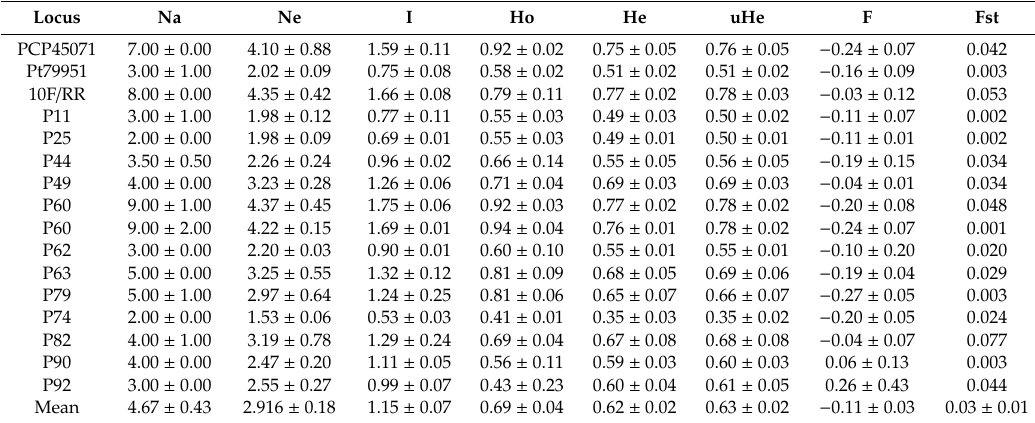
Table 2. Diversity statistics of the 16 microsatellite markers on 110 P. koraiensis clones grown at the Naozhi seed orchard.